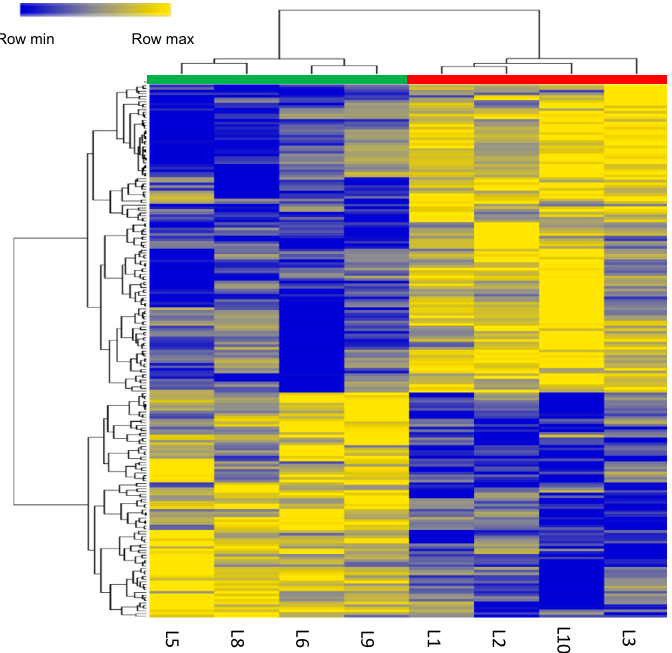
Figure 2. Heatmap of HCA using 201 differentially expressed genes ( p ≤ 0.05) between the LN (green) and HN (red) fetal livers. The row displays the gene and the column represents the sample. Genes with relatively low contents are displayed in dark blue, while genes with relatively high contents are displayed in yellow. The brightness of each color corresponds to the magnitude of the difference when compared with the average value.